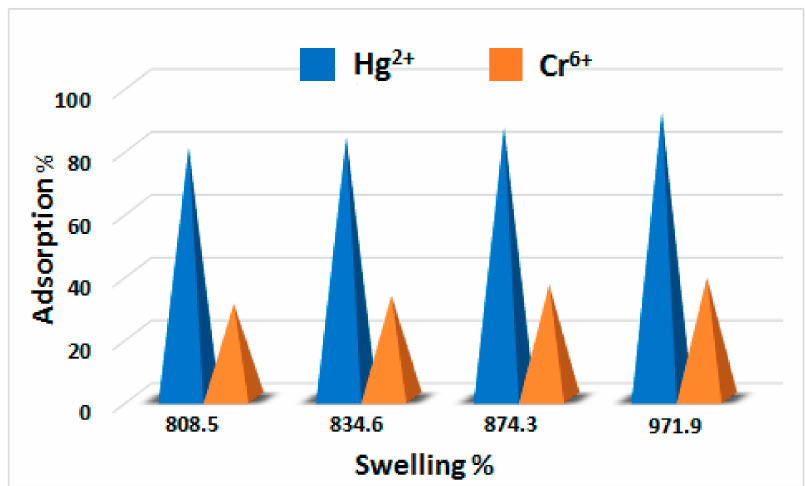
Figure 10. Adsorption percentage and swelling percentage of reduced graphene oxide incorporated gum tragacanth-cl- N,N -dimethylacrylamide (GT-cl-poly(DMA) / RGO) hydrogel